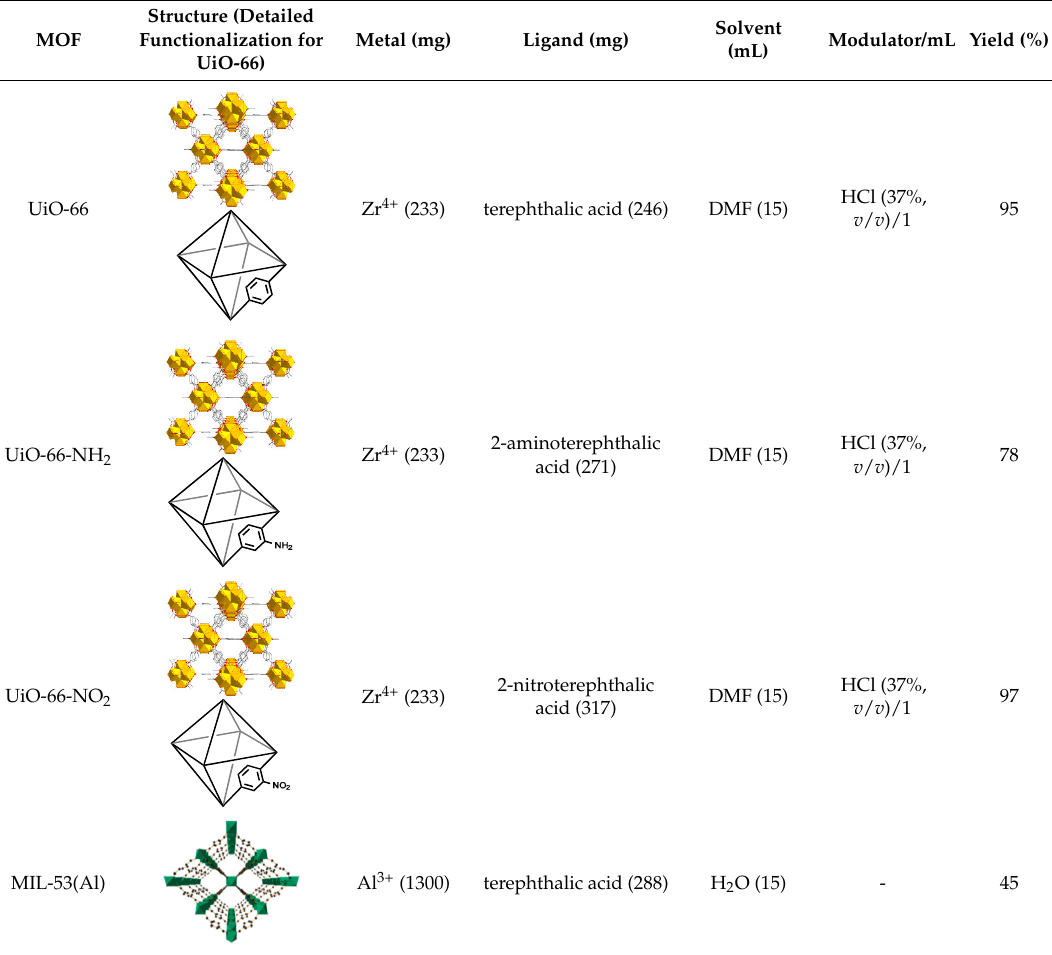
Table 1. Synthetic conditions of MOFs and yields obtained.